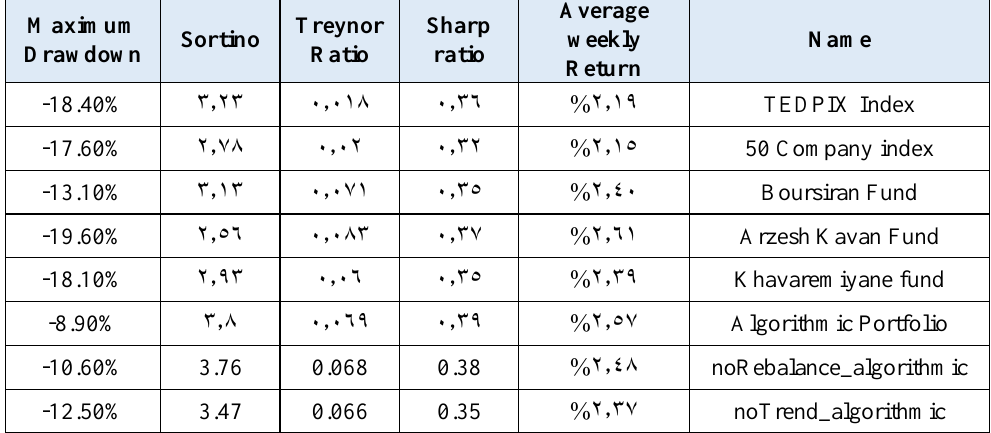
Table 7. Comparison of algorithmic portfolios with other funds in all